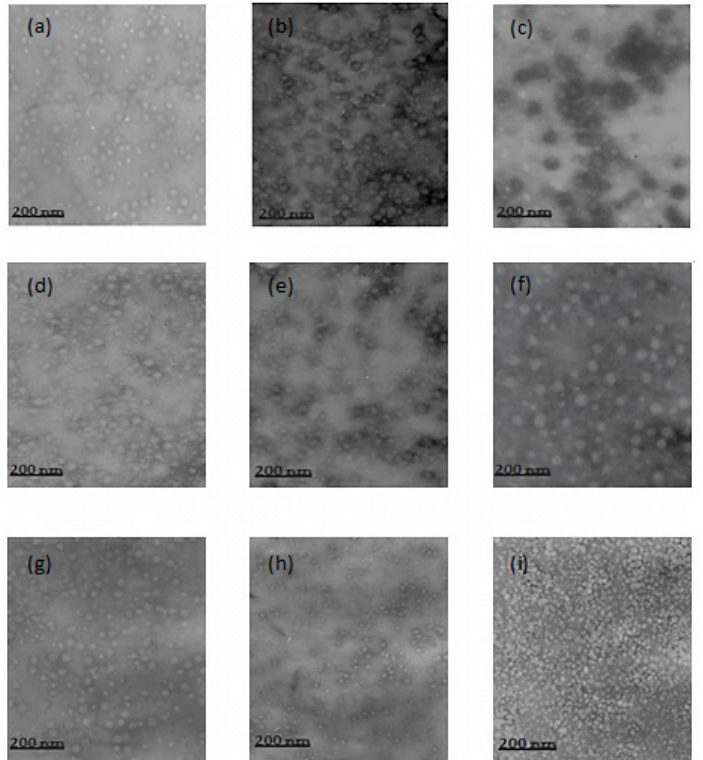
Figure1. Transmissionelectronmicroscopyimageof( a )0.5–0.5%, ( b )0.8–0.5%, ( c )1.0–0.5%, ( d )0.5–0.8%, Figure 1. Transmission electron microscopy image of ( a ) 0.5%–0.5%, ( b ) 0.8%–0.5%, ( c ) 1.0%–0.5%, ( d ) ( e ) 0.8–0.8%, ( f ) 1.0–0.8%, ( g ) 0.5–1.0%, ( h ) 0.8–1.0%, ( i ) 1.0–1.0% CS–PMAA 0.5%–0.8%, ( e ) 0.8%–0.8%, ( f ) 1.0%–0.8%, ( g ) 0.5%–1.0%, ( h ) 0.8%–1.0%, ( i ) 1.0%–1.0% CS–PMAA nanoparticles.